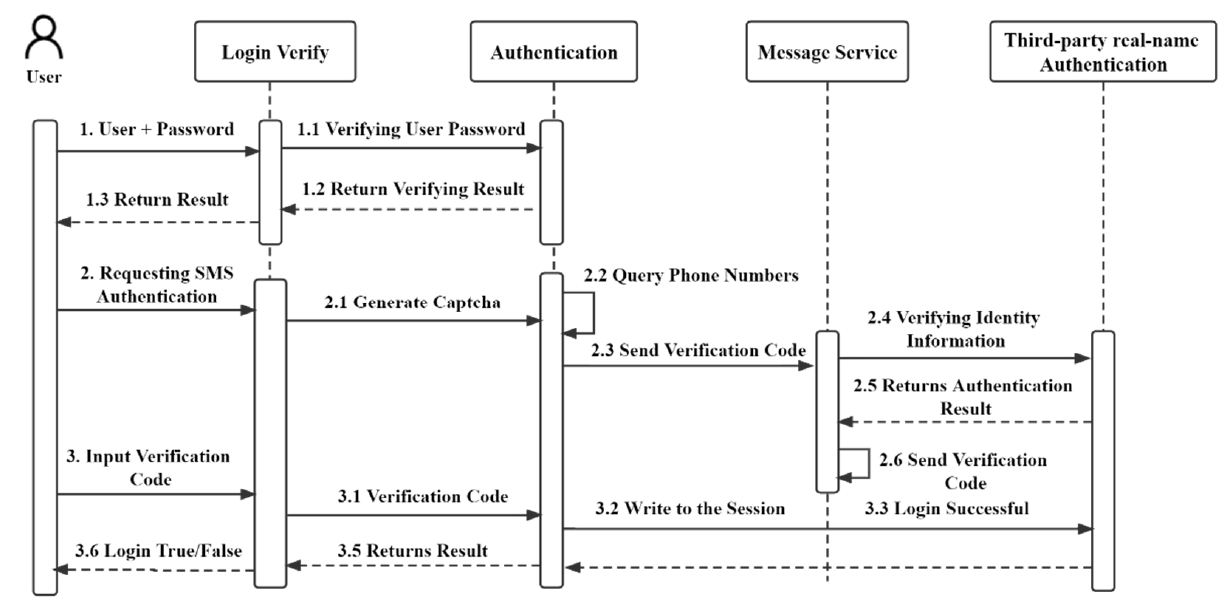
Figure 18. System login verification sequence diagram.